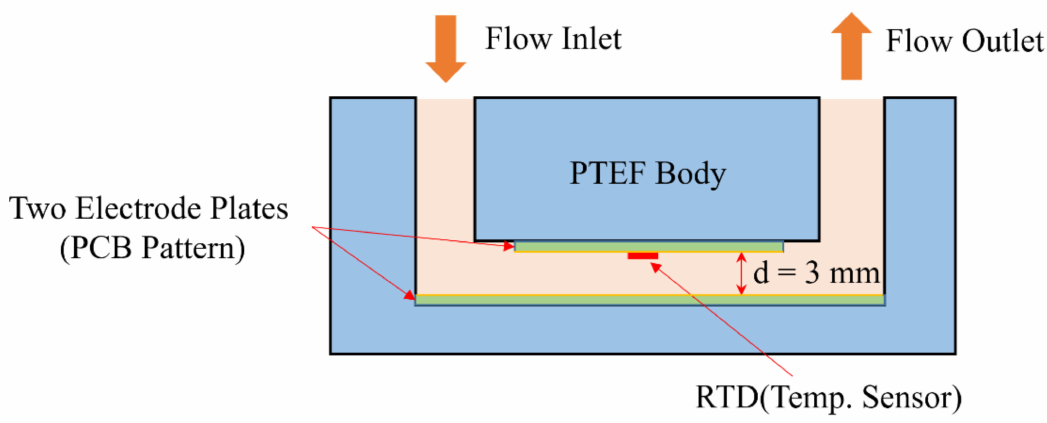
Figure 11. Basic structure of impedance sensor for epoxy flow.